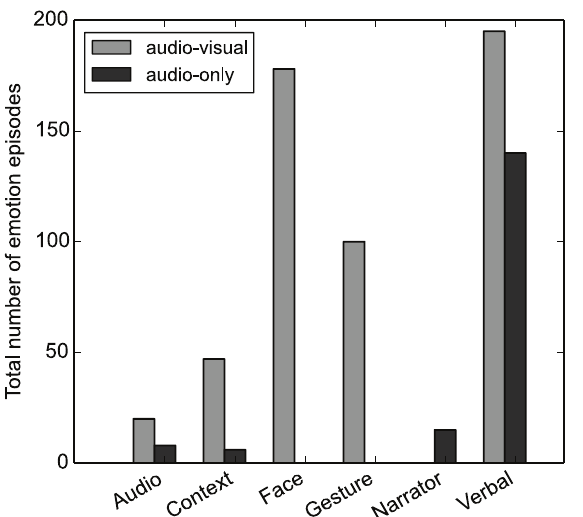
Figure 2. Number of emotion episodes for all distinguished onset cue categories (minimum 50% inter-rater agreement) for both stimulus types.